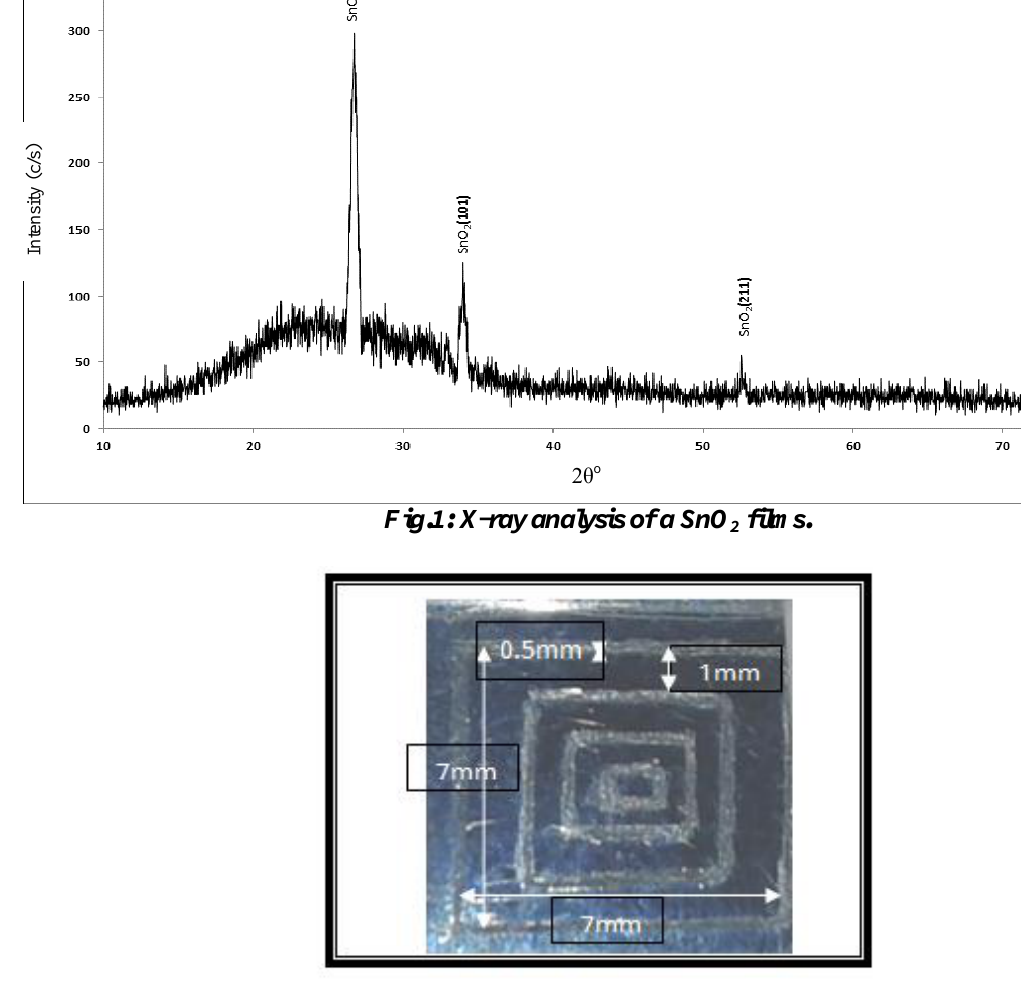
Fig.2: Detector SnO